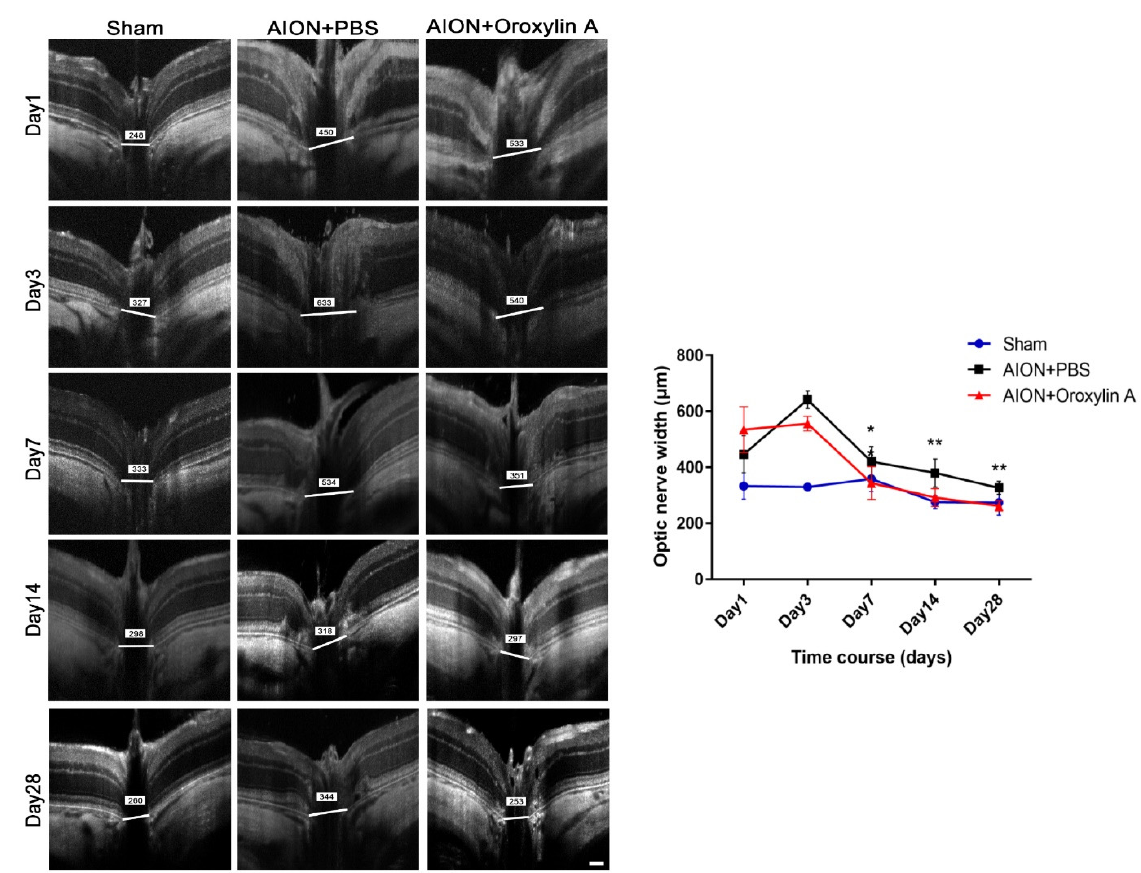
Figure 4. Optical coherence tomography (OCT) profiles of the optic nerve width (ONW). Representative ONW profiles for the sham, PBS-treated, and OA-treated groups on Days 1, 3, 7, 14, and 28. The ONW profile over time. The OA-treated group exhibited a significant reduction in edema on Days 7, 14, and 28 compared with the PBS-treated group. (420.73 ± 53.67 μ m versus 344.11 ± 59.01 μ m; 380.33 ± 49.90 μ m versus 292.60 ± 31.95 μ m; and 326.92 ± 23.26 μ m versus 262.42 ± 17.96 μ m, respectively). Results represent the means ± SDs. Scale bar, 130 μ m; ** p < 0.01; * p < 0.05; n = 6.